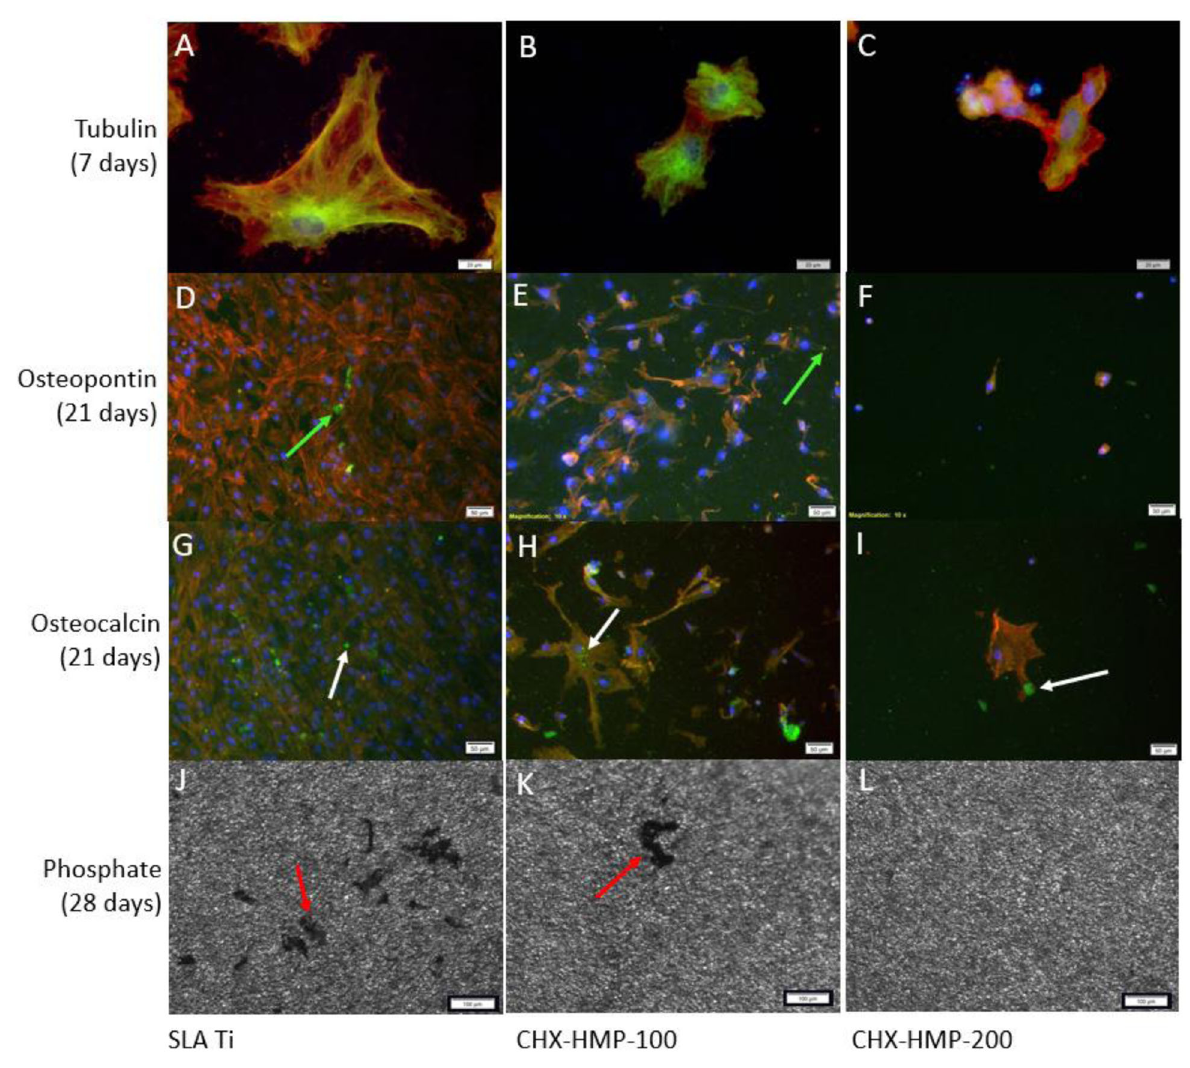
Fig. 5 Assessment of hMSC metabolism and differentiation after growth on SLA Ti, CHX-HMP-100, and CHX-HMP-200 coatings. Images A – C are colour composite micrographs of hMSCs grown for 7 days showing tubulin staining of microtubule networks (green), nuclei (blue), and actin (red). Images D – F are colour composite micrographs of hMSCs grown for 21 days showing osteocalcin staining of calci fi ed extracellular deposits (green arrows to green